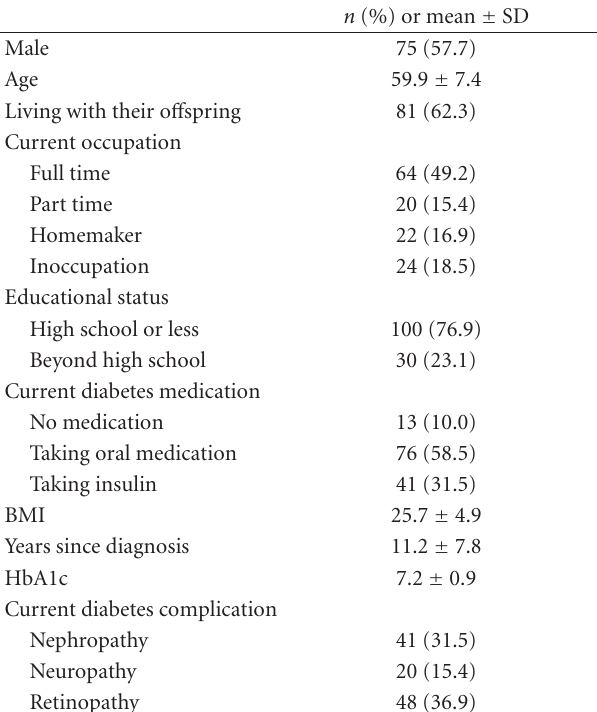
Table 2: Patient characteristics ( N =